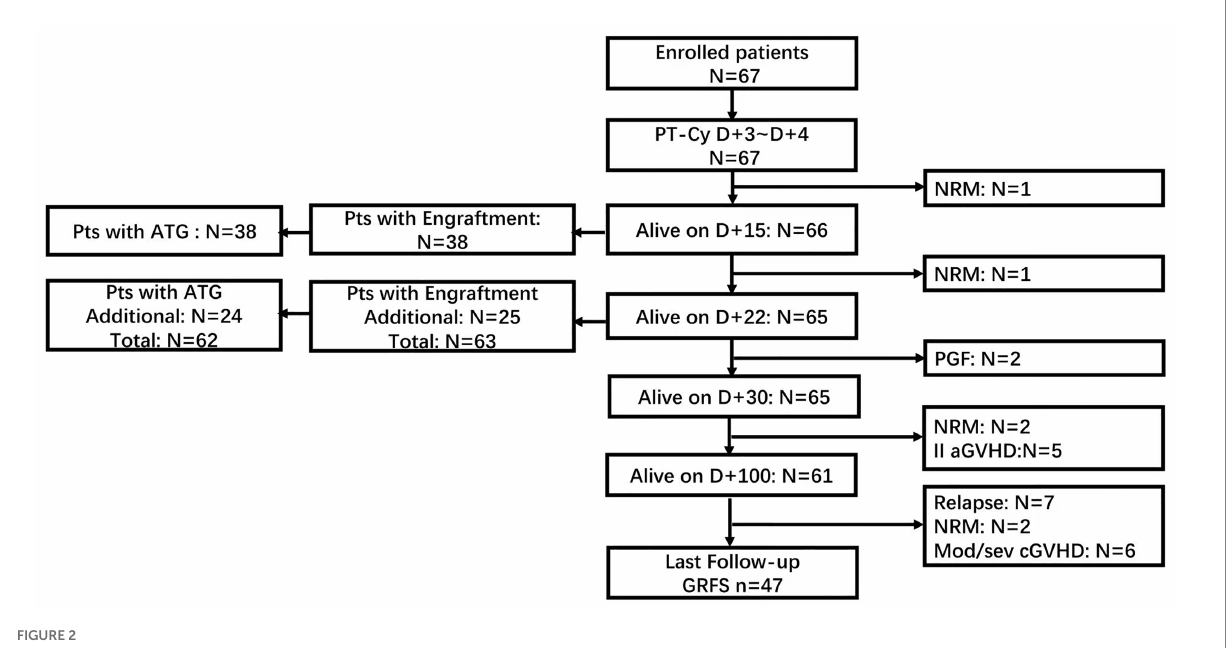
FIGURE 2 Treatment flowchart.